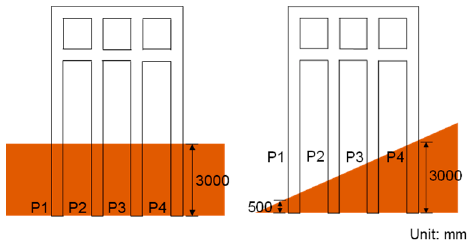
Figure 7. Riverbed geometry with/out simulated scour.